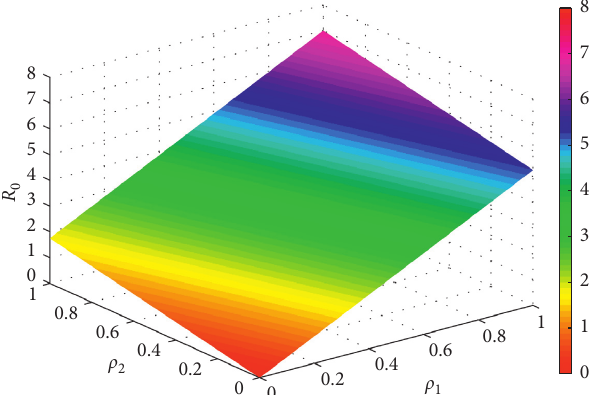
Figure 2: The influence of parameters ρ